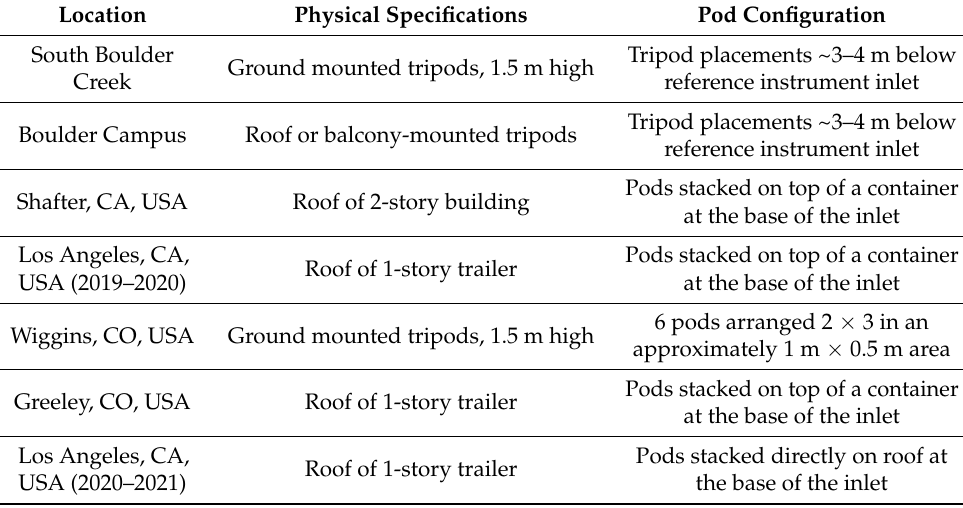
Table 1. Physical specifications for co-location